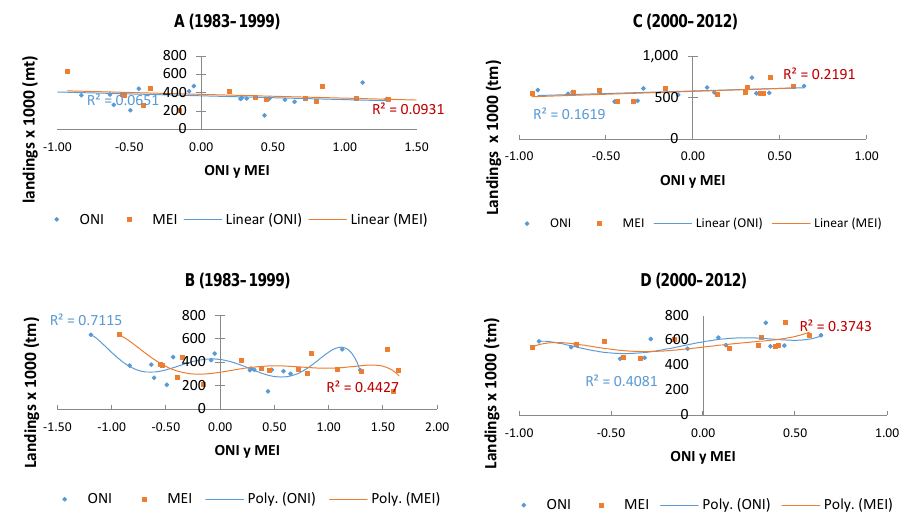
Figure 3. Total tuna landings in the EPO. Linear (a, c) and non-linear correlation ( b ; n = 6 and d , n = 5) MEI/ONI for time series 1983–1999 and 2000–2012. Data NOAA, CIAT (2013).